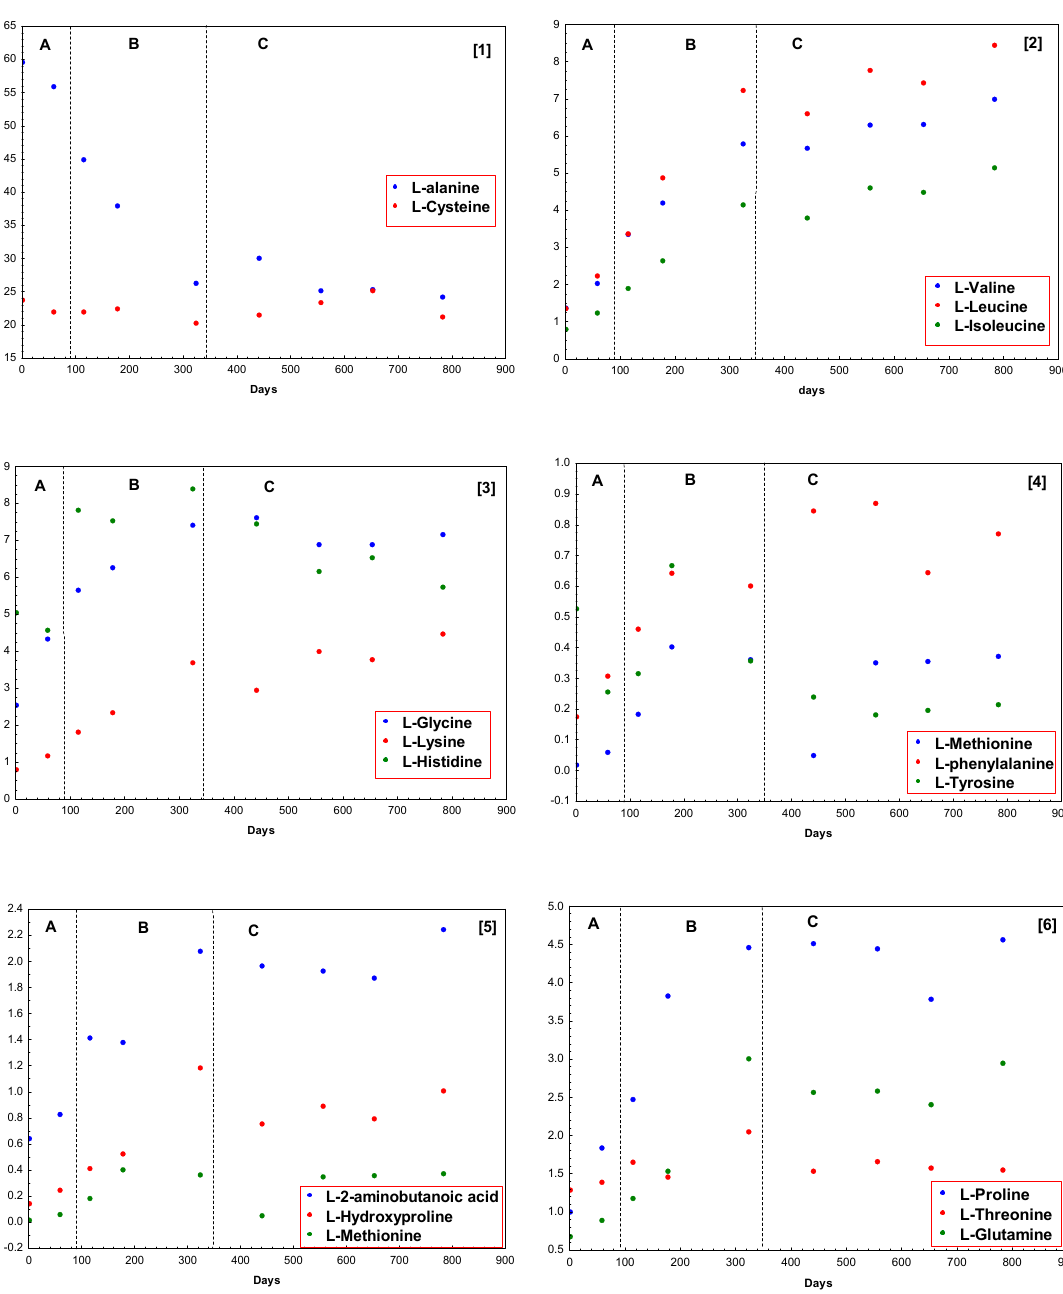
Figure 4. Variation of percentages of different amino acids (from 1 to 6) in Iberian dry-cured ham according to the ripening time. Table 5. Variation of concentration* of amino acids according to the ripening time.